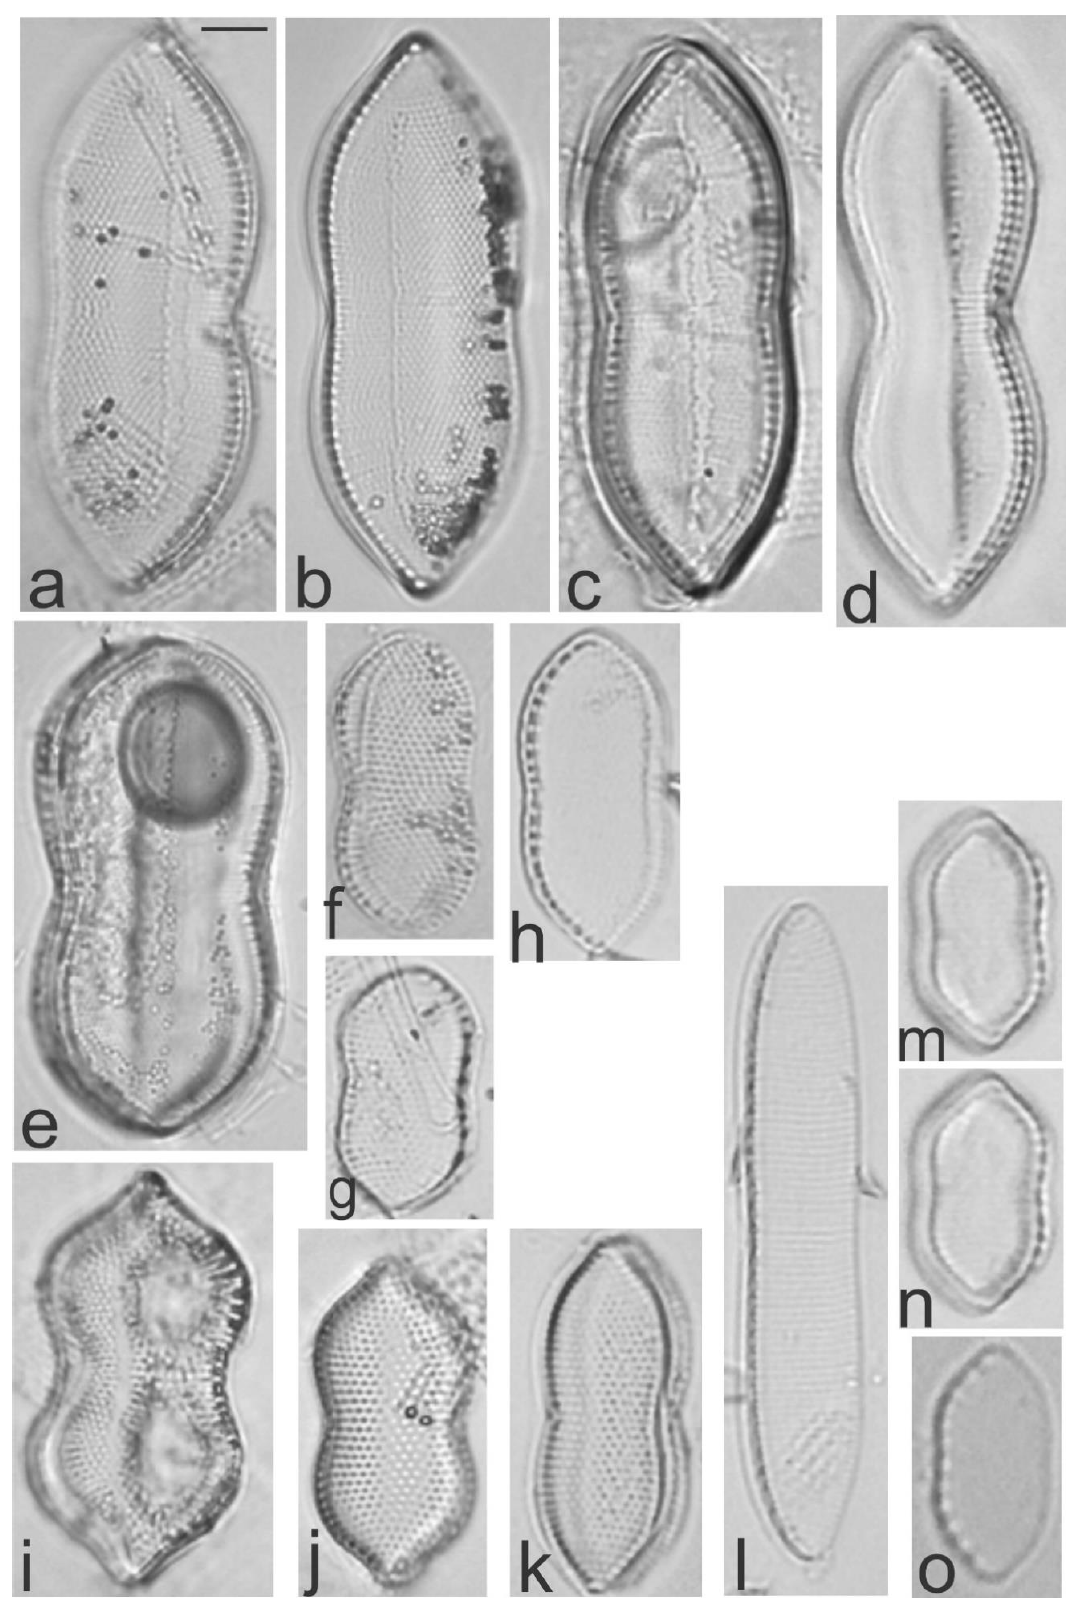
Figure 29. ( a – c ) Psammodictyon roridum ; ( d ) Tryblionella nicobarica ; ( e ) Psammodictyon panduriforme ; ( f , g , k ) P. constrictum ; ( h ) Tryblionella persuadens ; ( i ) Psammodictyon pustulatum ; ( j ) Tryblionella coarctata ; ( l ) Nitzschia jelineckii ; ( m , n ) Psammodictyon panduriforme var. continuum ; ( o ) P. rudum . Scale bar = 5 μm.